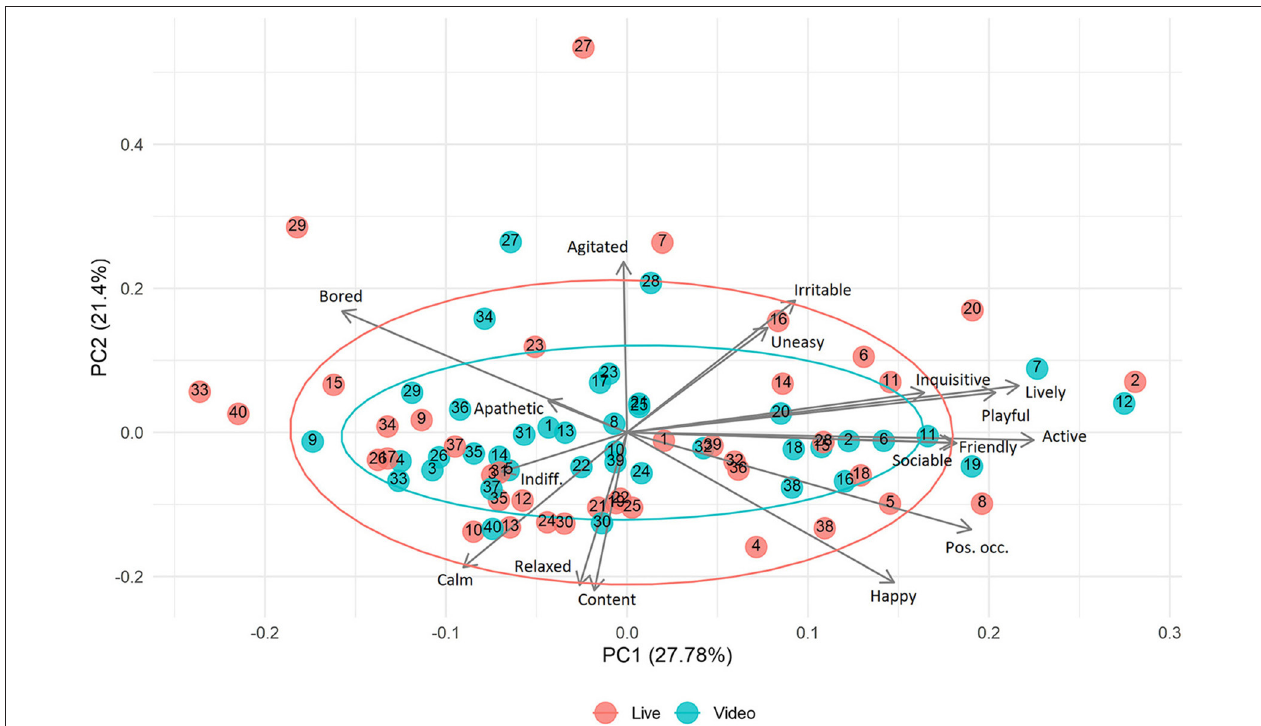
FIGURE 4 | PCA analysis QBA results from live and video assessments, determined by 17 terms. Points with the same number were of corresponding events (e.g., the paired live and video assessments of the same event). Ellipses represent 95% confidence.